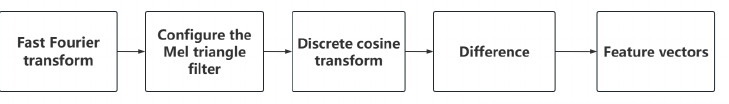
Figure 7. The process of feature